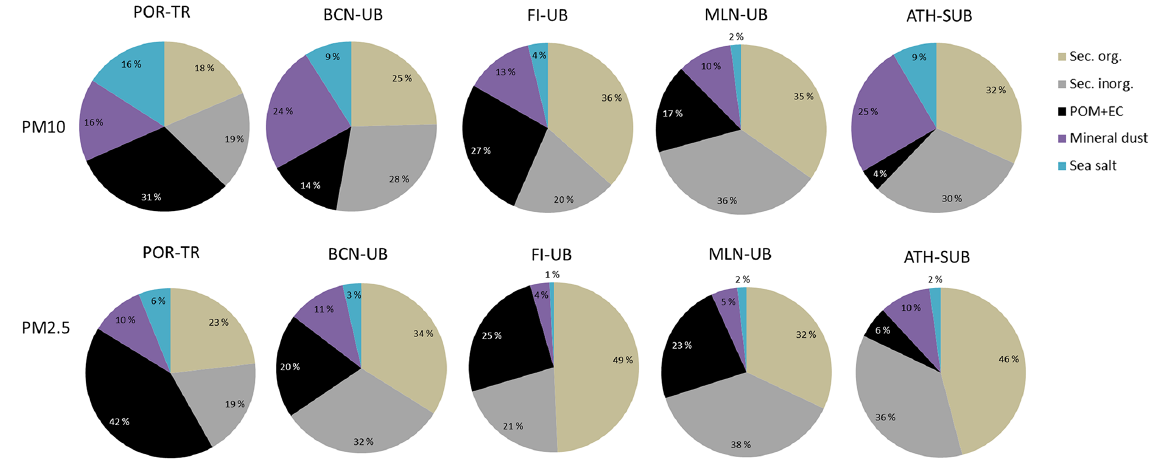
Figure 2. Secondary and primary PM components of the mean PM 10 and PM 2 . 5 levels at the five AIRUSE